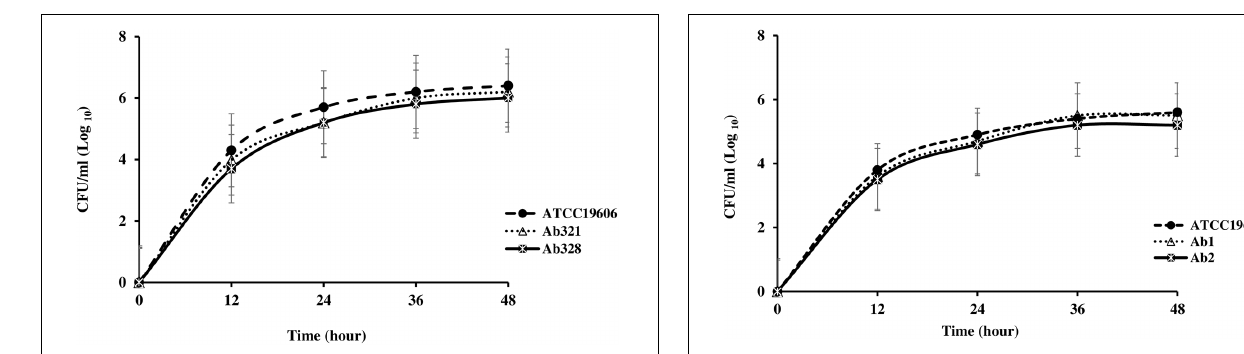
FIGURE 3 | Growth curves of reference strain ATCC 19606 and colistin-susceptible isolate: Ab1 and respective colistin-resistant isolate: Ab2. The growth rates between Col R isolate, Ab1, and their respective Col S isolate, Ab2, were not significantly different at any time points ( P > 0.05).